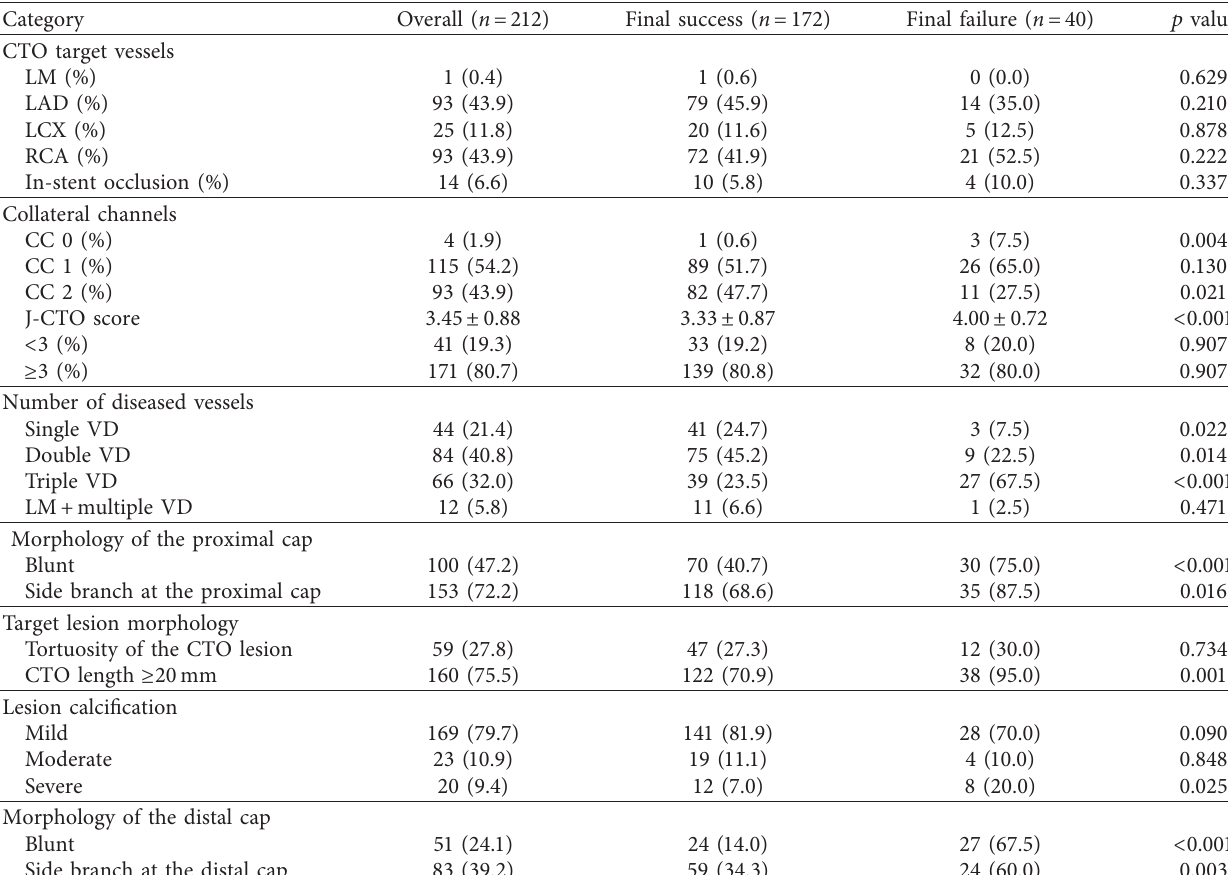
Table 2: Baseline angiographic characteristics of CTO